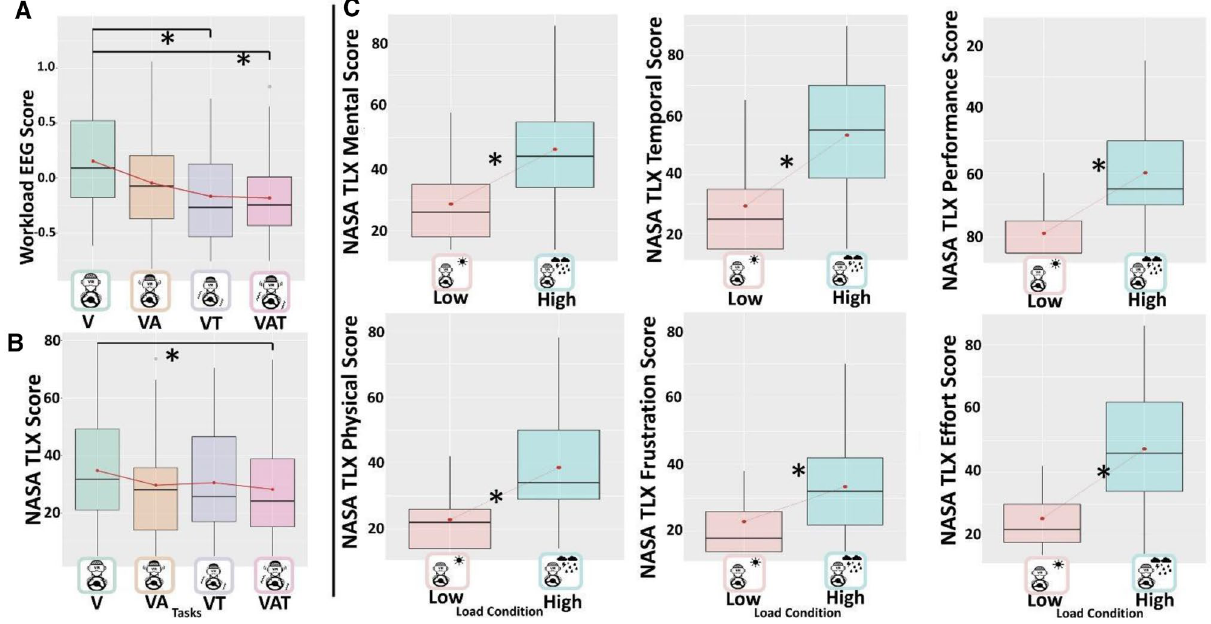
Figure 4. Boxplots representing ( A ) the EEG-based Workload index and ( B ) the workload experienced by the subjects, both across the Sensory Tasks. Panel C represents the different scales of the NASA TLX. The black asterisks indicate significant post-hoc tests while red dots and lines refer to the mean. The central line represents the median, the top and the bottom of the box are the first and third quartiles, and the whiskers are the interquartile range of the lower quartile and of the upper quartile multiplied by 1.5. Performance score scale is inverted (from 100 to 0), coherently with the NASA-TLX questionnaire. In fact, in the workload evaluation, a lower performance means a higher perceived workload.